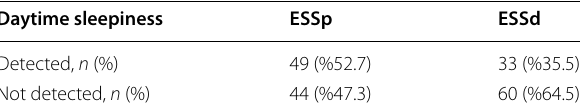
Table 4 Distribution of daytime sleepiness according to ESSp and ESSd